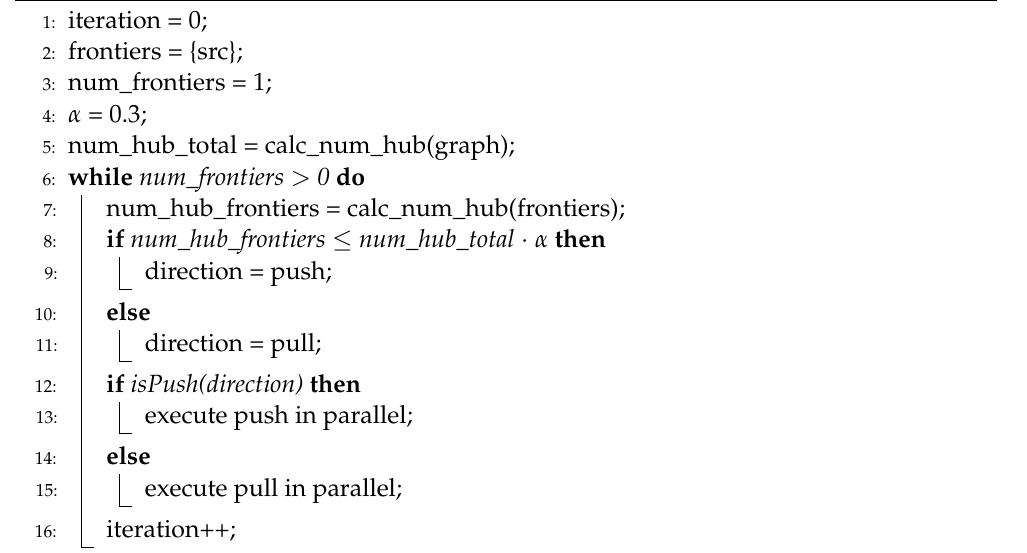
Algorithm 6 Direction-optimizing BFS in